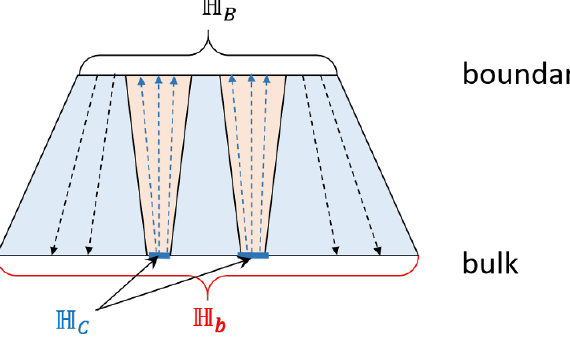
Figure 2 . Illustration of the structure of bidirectional holographic code de(cid:12)ned by RTN. An isometry is de(cid:12)ned from the boundary Hilbert space H B to bulk Hilbert space H b which maps each state in H B to a superposition of geometries. In the code subspace H C which consists of subspaces of small (cid:13)uctuations around di(cid:11)erent classical geometries, an isometry is de(cid:12)ned from bulk to